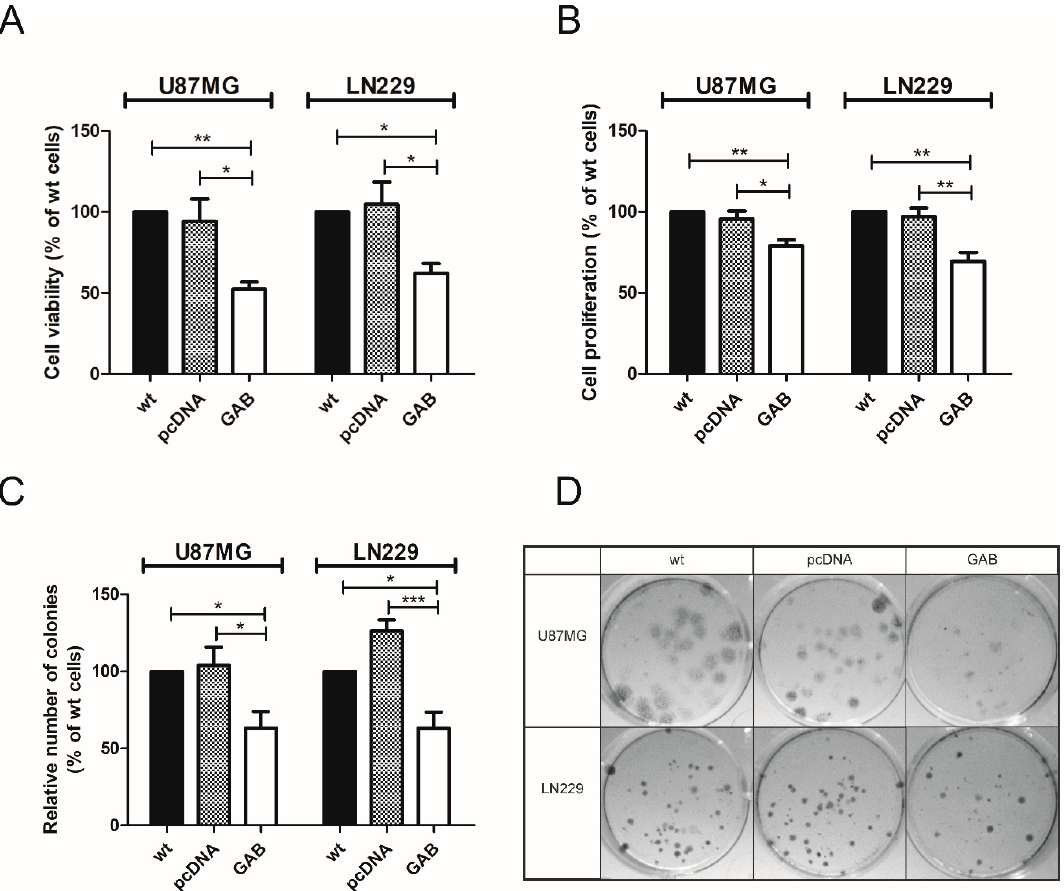
Figure 2. Transfection with the GAB sequence diminishes the viability, proliferation, and ability to form colonies of U87MG and LN229 cells. ( A ) Mitochondrial activity of wild type (wt) cells or cells stably transfected with the indicated plasmids was assessed by the MTT test 48 h after seeding. Results are mean ± SD ( n = 4) expressed as a percentage of wt cells. * p < 0.05, ** p < 0.01 versus wt and pcDNA cells (one-way ANOVA followed by Tukey’s test). ( B ) Cell proliferation of wild type (wt) cells or cells stably transfected with the indicated plasmids was assessed by the BrdU assay 48 h after seeding. Results are mean ± SD ( n = 4) expressed as a percentage of wt cells. * p < 0.05, ** p < 0.01 versus wt and pcDNA (one-way ANOVA followed by Tukey’s test). ( C ) Colony formation 3 weeks after seeding: the number of colonies are represented as a percentage relative to the number of colonies formed by wt cells. Results are mean ± SD ( n = 5–7). * p < 0.05, *** p < 0.001 versus wt and pcDNA cells (one-way ANOVA followed by Tukey’s test). ( D ) Representative images of the plates with colonies formed within 3 weeks of growth.